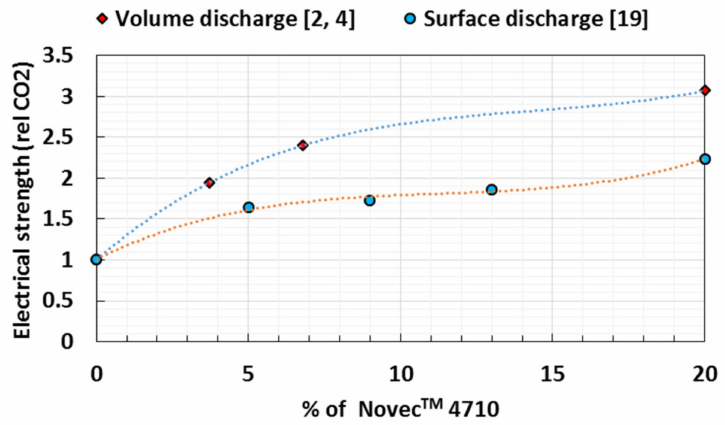
Figure 1. Electrical strength (ES) relative to CO 2 for di ff erent Novec TM 4710 / CO 2 gas mixtures in uniform electric field (Volume discharge [2,4] vs. Surface discharge (epoxy insulator)